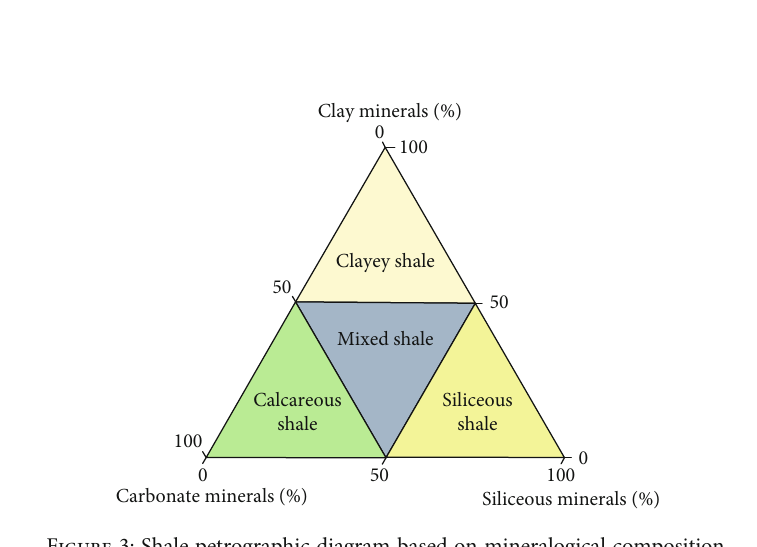
Figure 3: Shale petrographic diagram based on mineralogical composition.